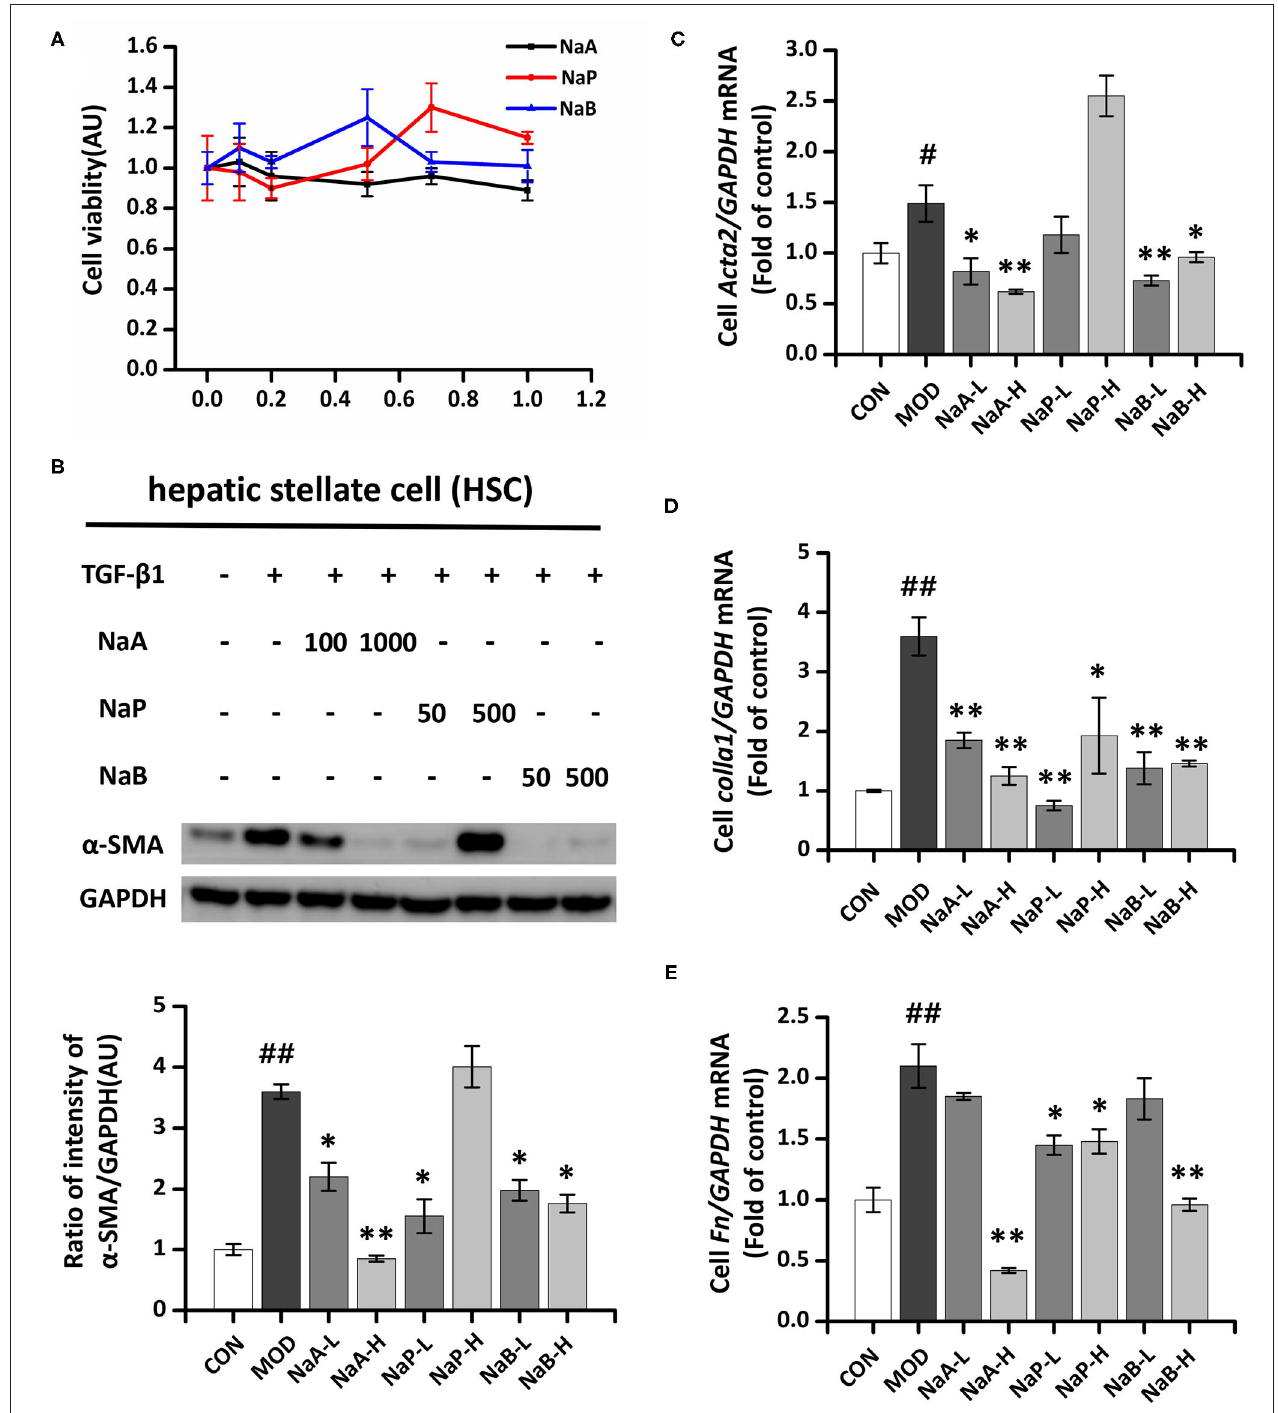
FIGURE 1 | Effects of SCFAs on TGF- β 1 induced LX2 cells activation. (A) SCFAs cytotoxic effects. After serum starvation for 12h, a CCK8 assay was performed for LX2 cells treated with SCFAs at doses of 0–1mM for 48h. (B) The protein expression of α -SMA was assessed by the Western blot. LX2 cells were treated with or without 2.5ng/ml TGF- β 1 and 1mM of SCFAs for 48h. (C–E) Real-time PCR was used to evaluate the mRNA expressions of Acta2, Col1a1, and Fn . LX2 cells were treated with or without 2.5ng/ml TGF- β 1 and 1mM of SCFAs for 48h. LX2 cells were treated as detailed in the section Materials and Methods. For all bar graphs, data are the mean ± SD, # p < 0.05, ## p < 0.01, as compared with CON, and * p < 0.05, ** p < 0.01, as compared with MOD. The significant difference was assessed using the one-way ANOVA followed by LSD post-tests. Control group (CON), group model cell treated with a TGF- β 1 (MOD), low dose of sodium acetate (NaA-L), high dose of sodium acetate (NaA-H), low dose of sodium propionate (NaP-L), high dose of sodium propionate (NaP-H), low dose of sodium butyrate (NaB-L), high dose of sodium butyrate (NaB-H), arbitrary unit (AU).